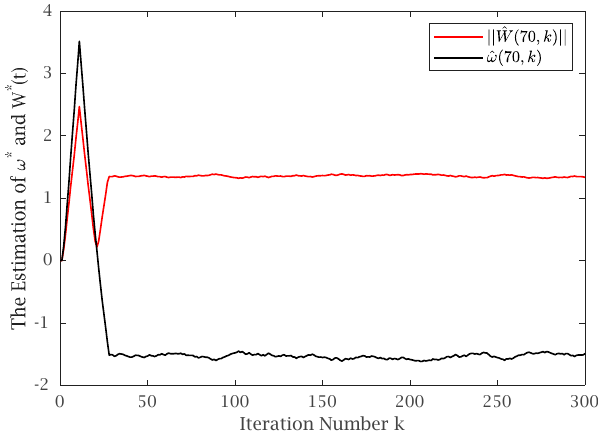
Figure 8. Estimation of parameters ω (cid:3549)( t , k ) and W (cid:3553) ( t , k ) at t = 70.